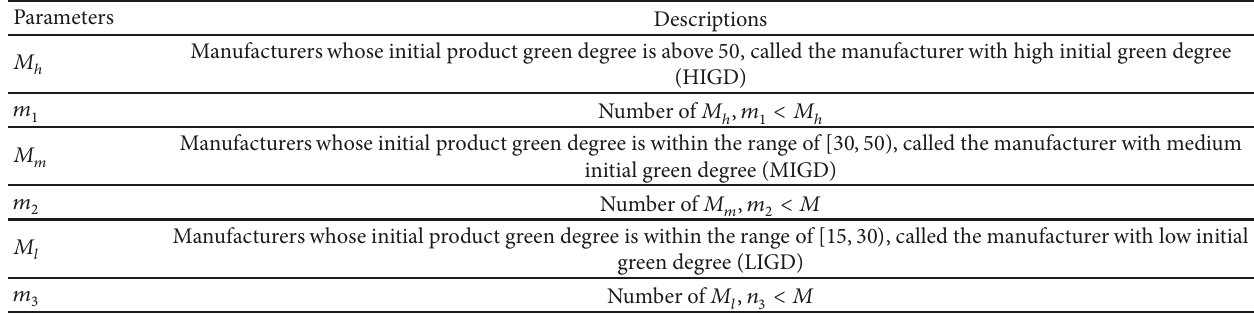
Table 2: Descriptions of manufacturers’ categories.